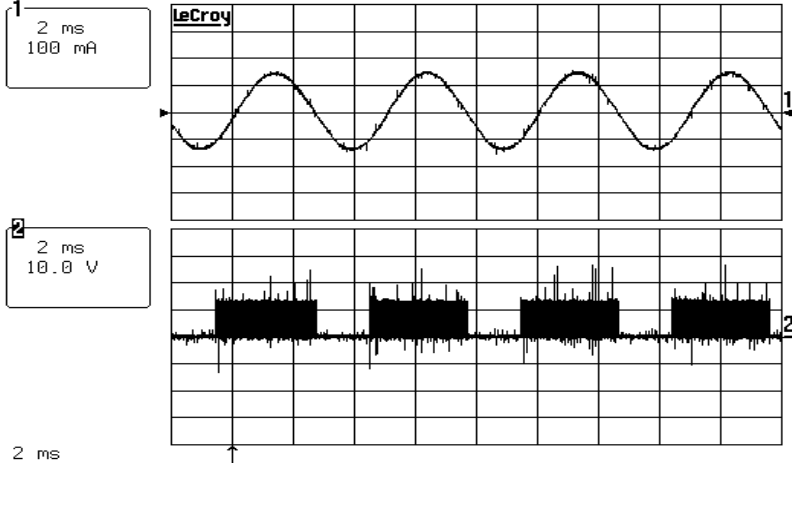
Figure 13. Experimental results of the current and voltage waveforms (3000 rpm, 1.3